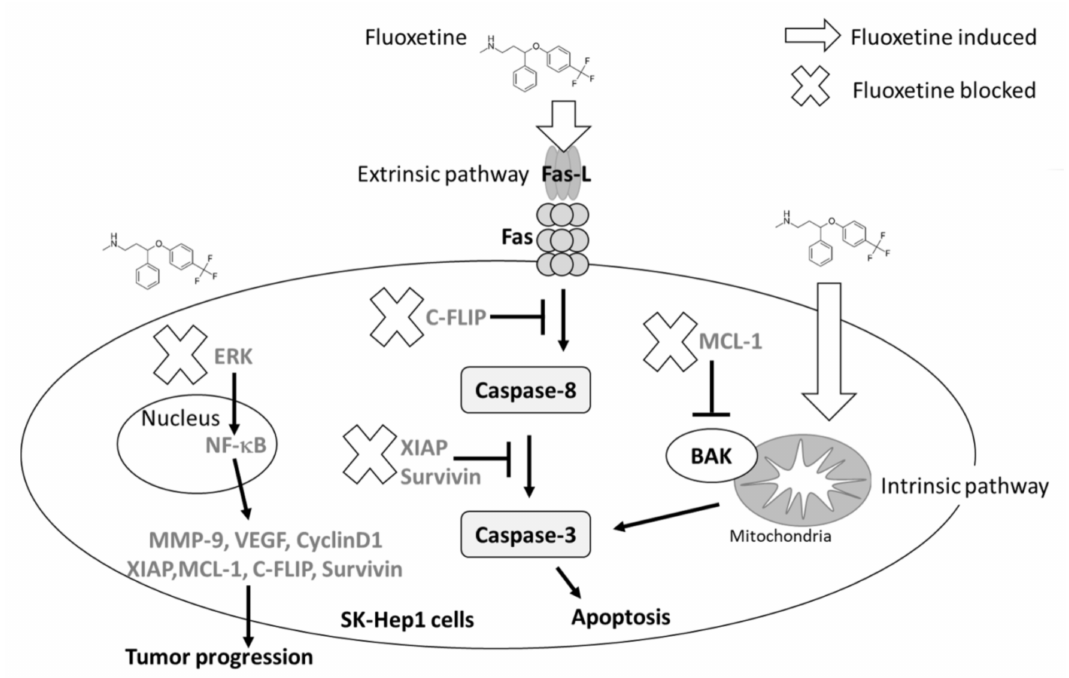
Figure 5. The potential anti-HCC properties of fluoxetine. Fluoxetine induces apoptosis through extrinsic/intrinsic pathways and inhibits ERK/NF- κ B-modulated anti-apoptotic and metastatic activity in SK-Hep1 and Hep3B